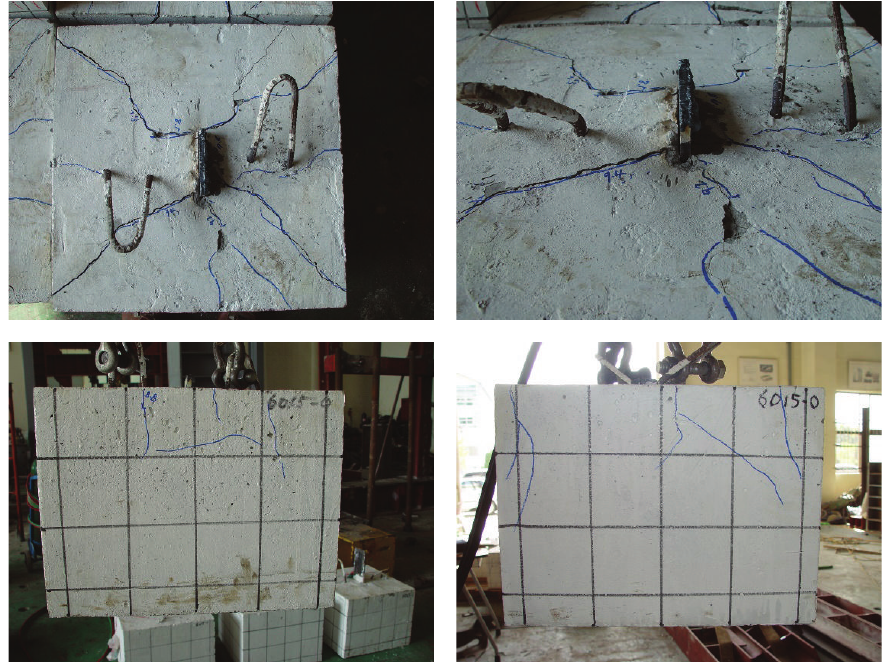
Figure 8: Failure mode of specimen PO-6015-N (Type